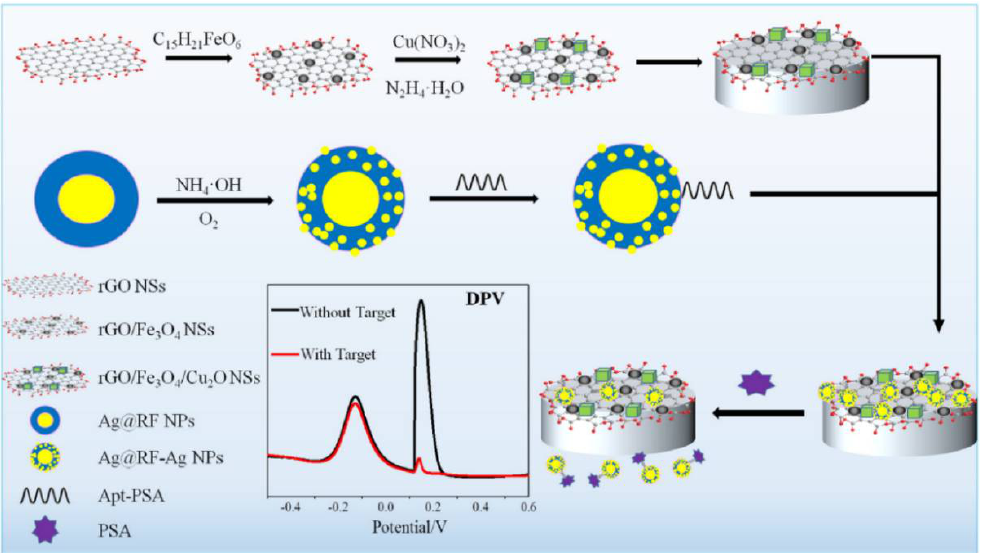
Figure 7. Schematic illustration of the electrochemical ratiometric aptamer-based assay for PSA [204]. Copyright (2020) Elsevier, reprinted with permission.